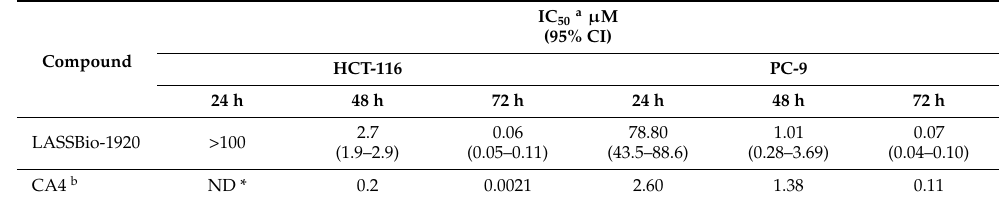
Table 2. Cytotoxic effect of LASSBio-1920 at different concentrations (0.01–100 µ M) against HCT-116 and PC-9 human tumor cells after 24, 48, and 72 h of incubation using MTT assay.